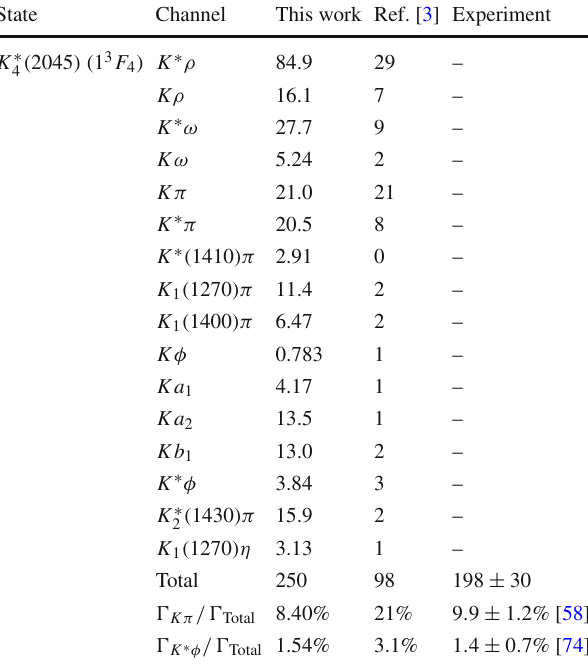
( 2045 ) assigned to a 1 3 F 4